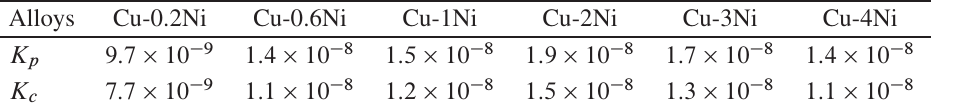
Table 2. Parabolic rate constants K p (g 2 cm (cid:3) 4 s (cid:3) 1 / and K c (cm 2 s (cid:3) 1 / measured for the oxidation of the present Cu-Ni alloys under 1 atm O 2 at 800°C.